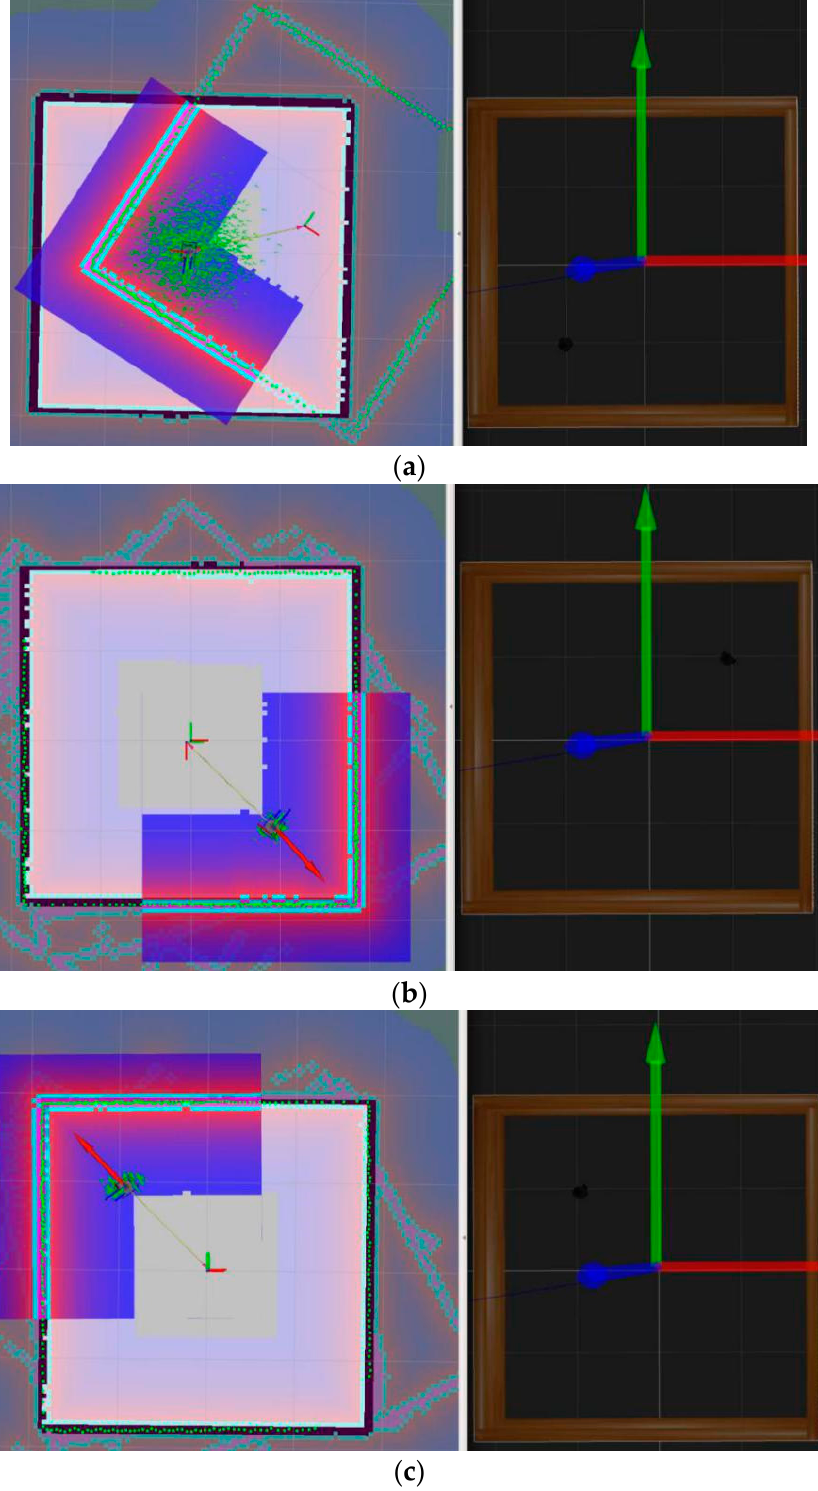
Figure 8. Turtlebot3_burger relocalization and navigation in a square environment. ( a ) Robot initialization with a previously built map. ( b ) Robot relocalization with a manually set wrong position. ( c ) Robot relocalization with a manually set correct position.